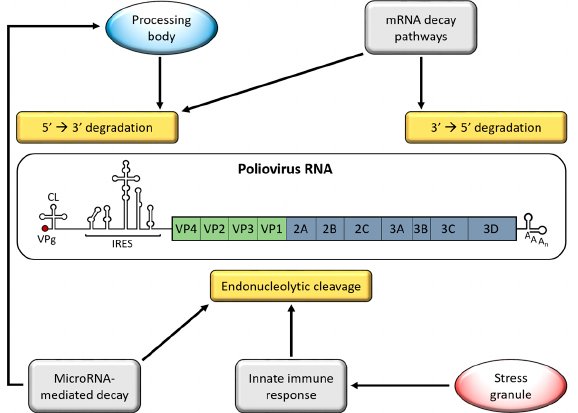
Figure 1. Poliovirus interactions with host RNA decay pathways. Picornavirus RNAs are exposed to degradation machinery from multiple RNA decay pathways and processes including 5 (cid:48) → 3 (cid:48) degradation in processing bodies (PBs), 5 (cid:48) → 3 (cid:48) or 3 (cid:48) → 5 (cid:48) degradation by mRNA decay pathways, and endonucleolytic cleavage as a result of activation of the innate immune response or microRNA-mediated decay. Poliovirus RNA serves as a model for the picornavirus genome. Genomic RNA is linked to a small virus-encoded protein, VPg, at the 5 (cid:48) terminus. The 5 (cid:48) non-coding region (NCR) contains a cloverleaf structure (CL) and an internal ribosome entry site (IRES). A single open reading frame codes both structural (VP1-4) and non-structural (2A-3D) proteins that are proteolytically processed into precursor and mature viral proteins. The 3 (cid:48) end of the genome encodes a 3 (cid:48) NCR and poly(A)